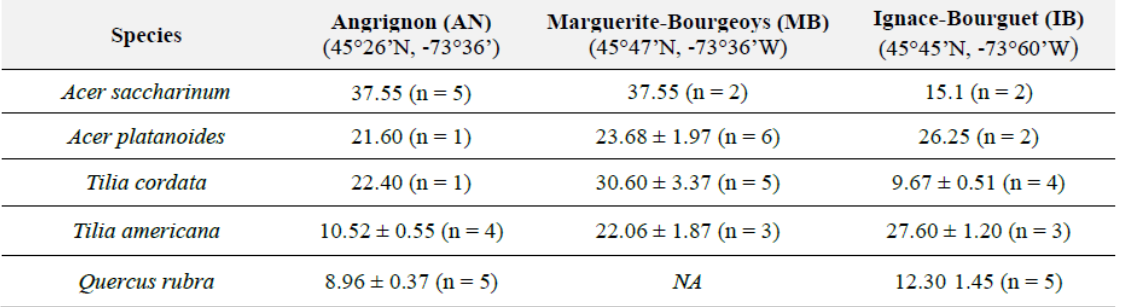
Table 1. Mean (± SD) diameter at breast height (in cm) and number of trees initially selected for each park and